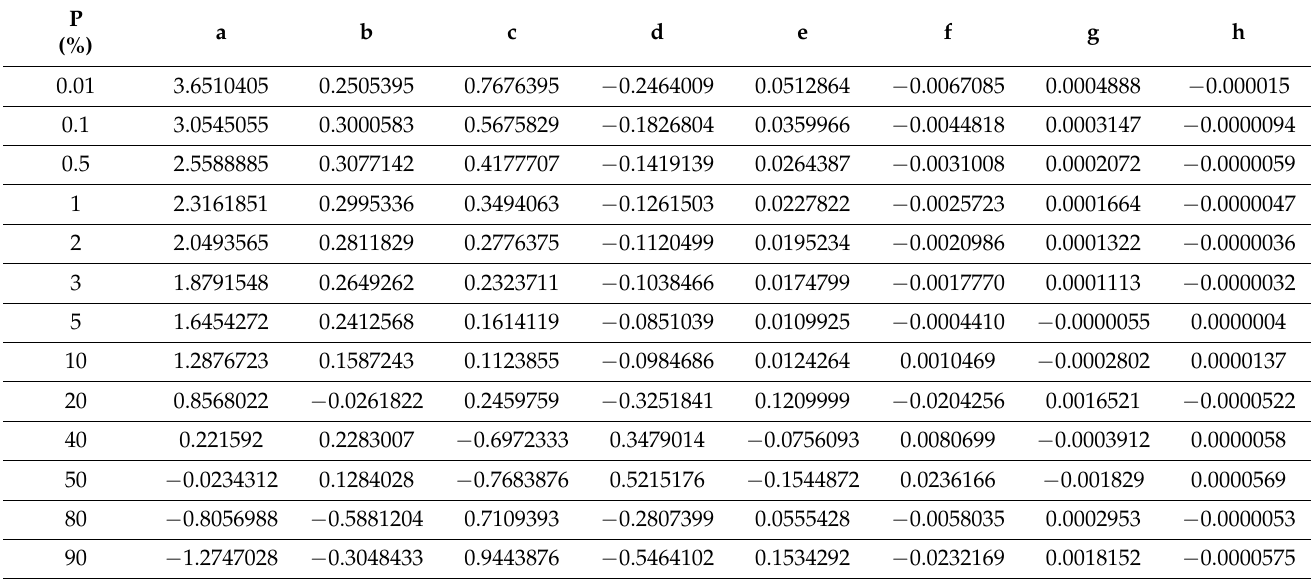
Table A6. The frequency factor for estimation with MOM for Wilson-Hilferty.